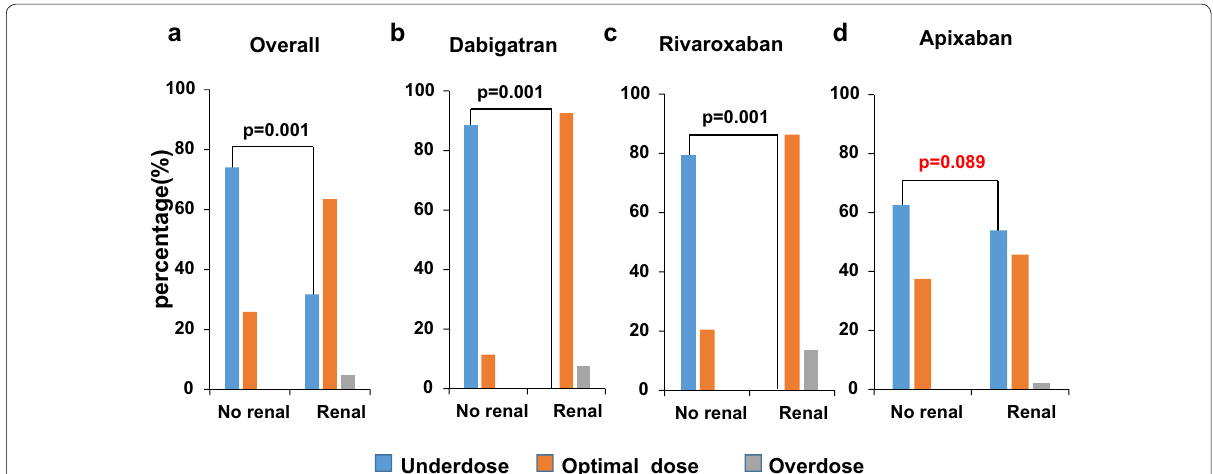
Fig. 4 Dosage of non‑vitamin K oral anticoagulants in patients without and with renal dose reduction indication. a Overall, b dabigatran, c rivaroxaban, and d apixaban